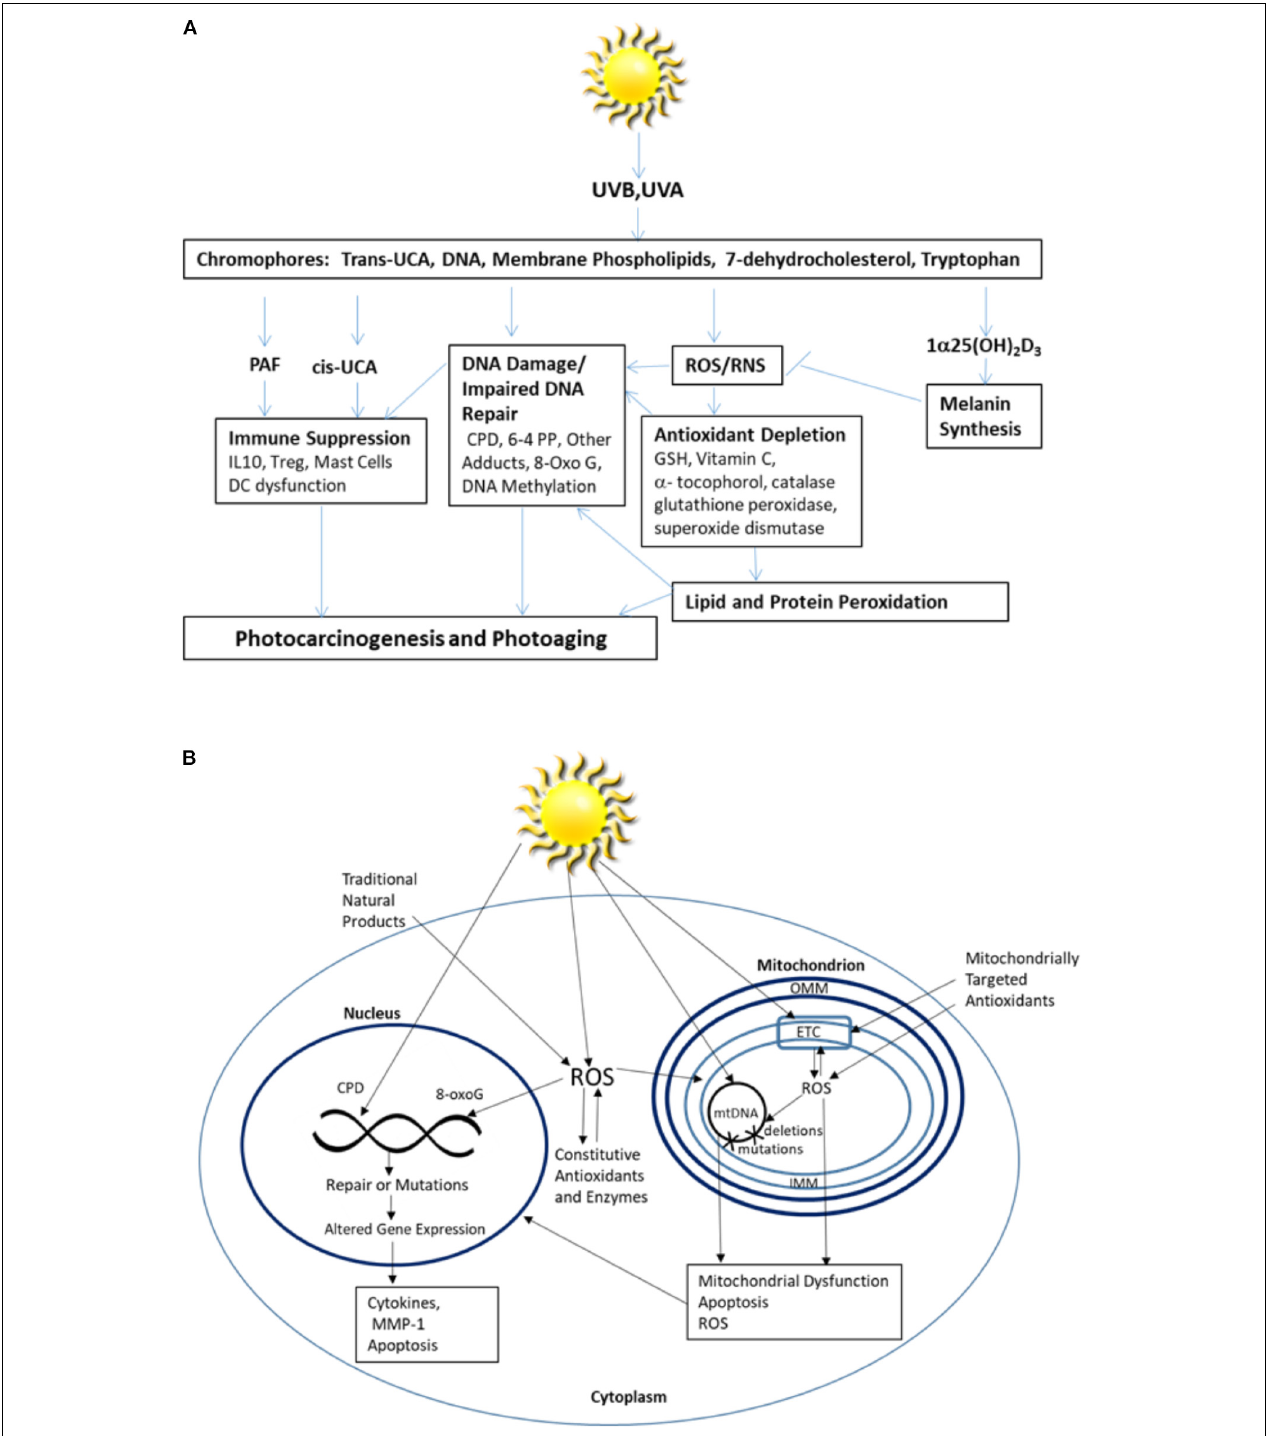
FIGURE 1 | (A) Skin responses to excessive UV radiation and (B) the intracellular impact of excessive UV radiation.